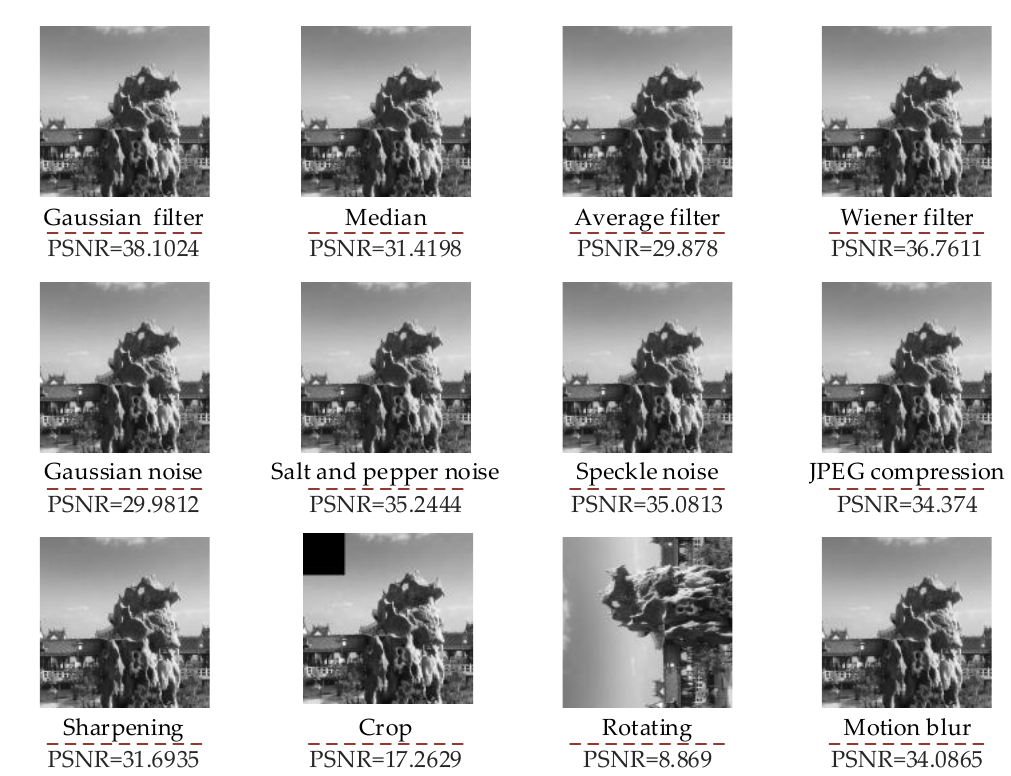
Figure 9. Watermarked images under various attacks.